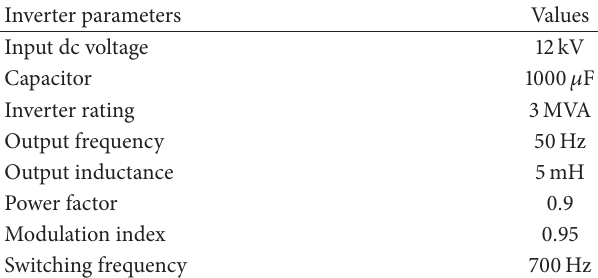
Table 8: Simulation parameters.